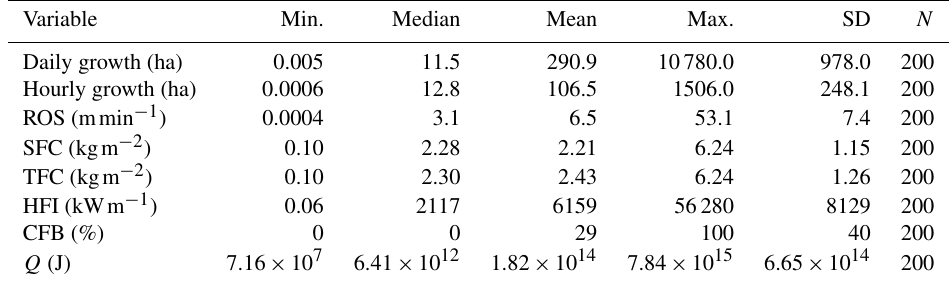
Table 5. A summary of fire behaviour characteristics.